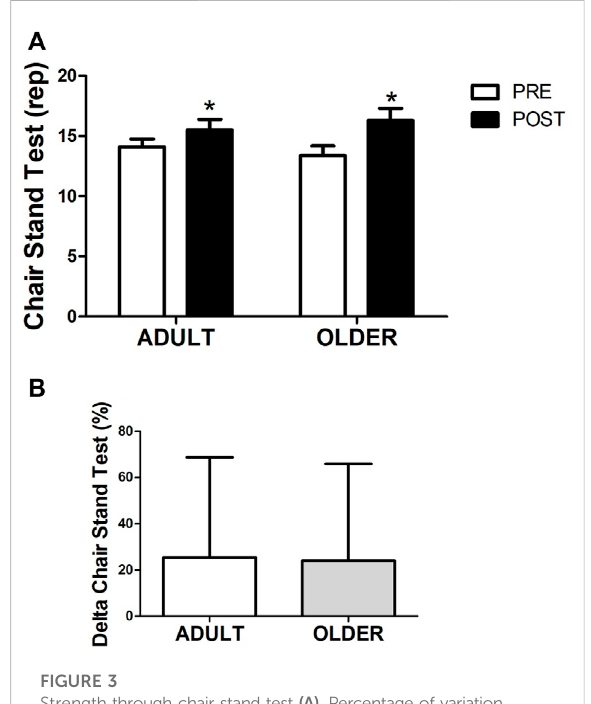
FIGURE 3 Strength through chair stand test (A) . Percentage of variation between PRE and POST in leg strength (B) is also shown. n = 20 participants in the ADULT group and n = 19 participants in the OLDER group. Data were analyzed using a repeated-measures ANOVA (A) and an independent samples t-test (B) . * p < 0.05 (time